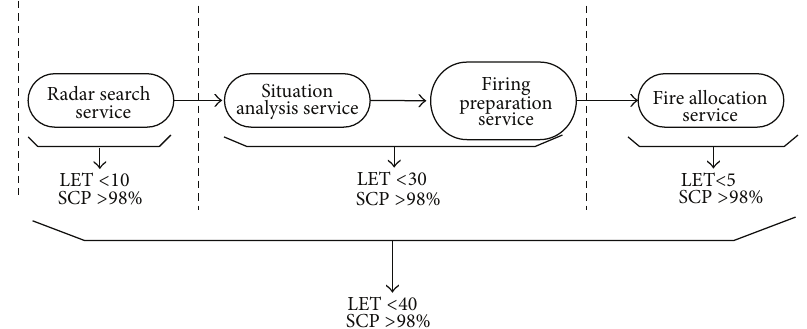
Figure 2: The service composition model under